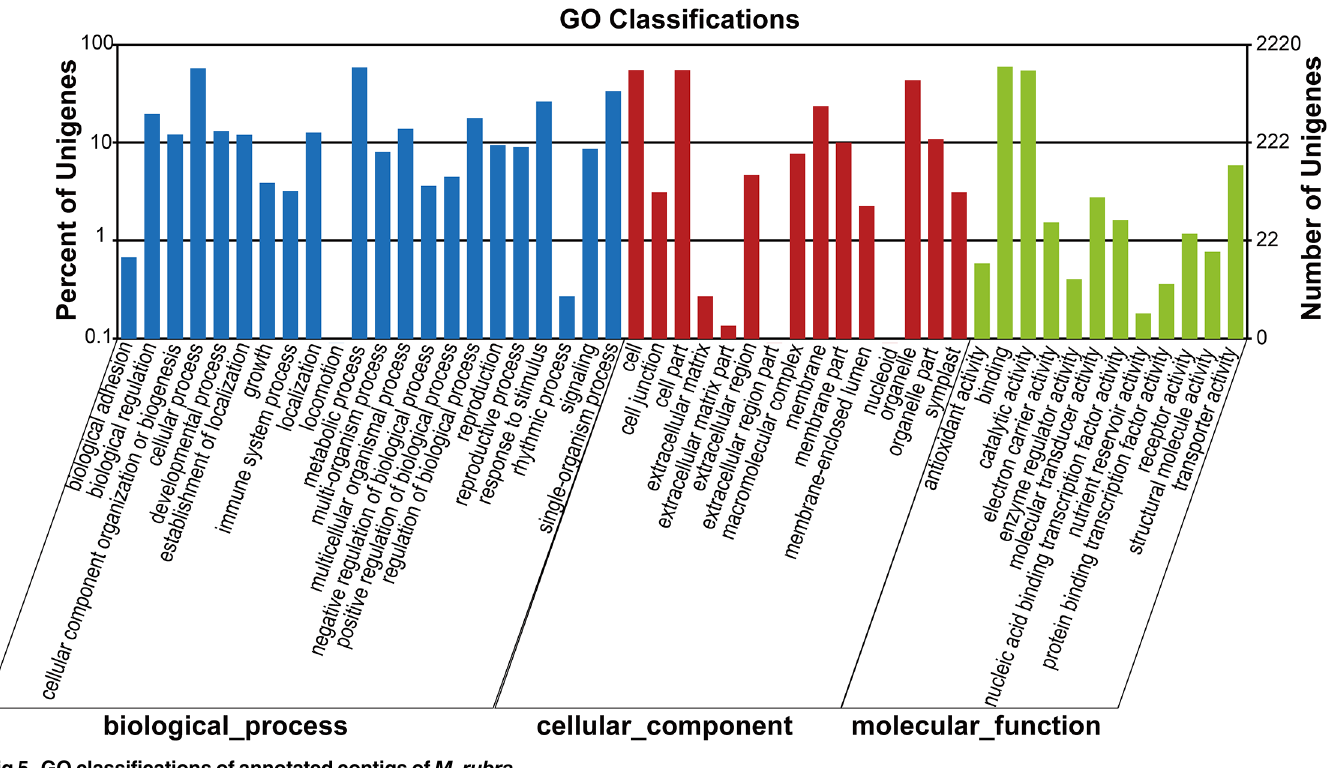
PLOS ONE | DOI:10.1371/journal.pone.0139840 October 2,